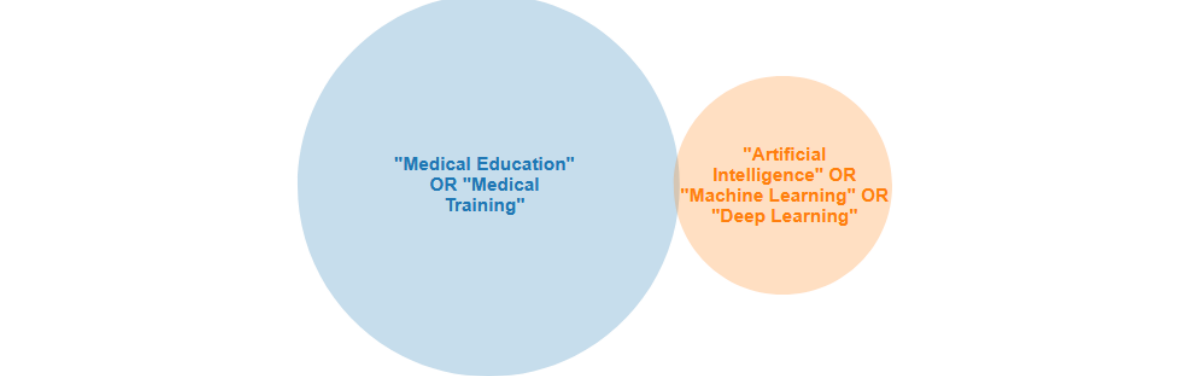
Figure 2. Venn diagram for the PubMed search. A total of 363 results were found with the following search terms: ("Medical Education" OR "Medical Training") AND ("Artificial Intelligence" OR "Machine Learning" OR "Deep